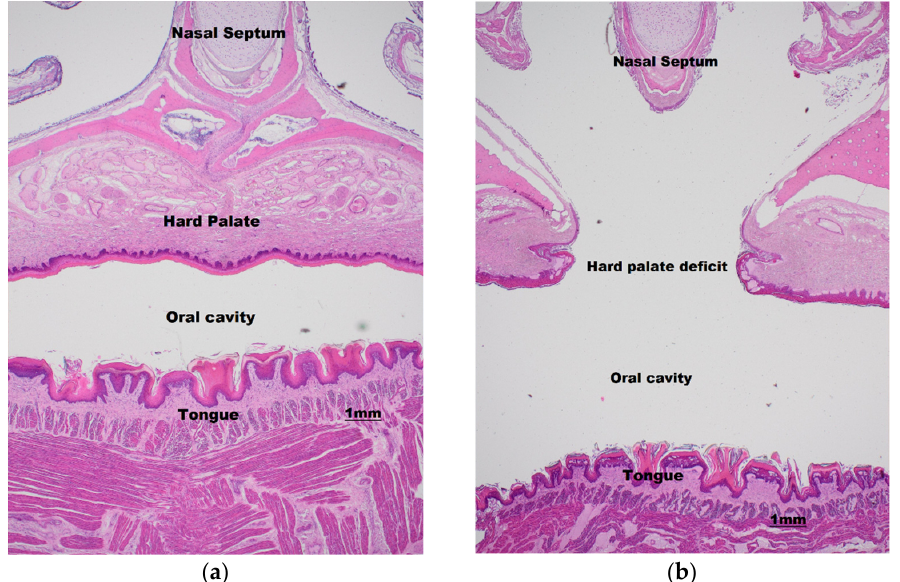
Figure 3. Hematoxylin and eosin-stained 20× maxilla cross section of a normal neonate palate ( a ) and cleft palate syndrome affected neonate ( b ) showing midline hard palate deficit.